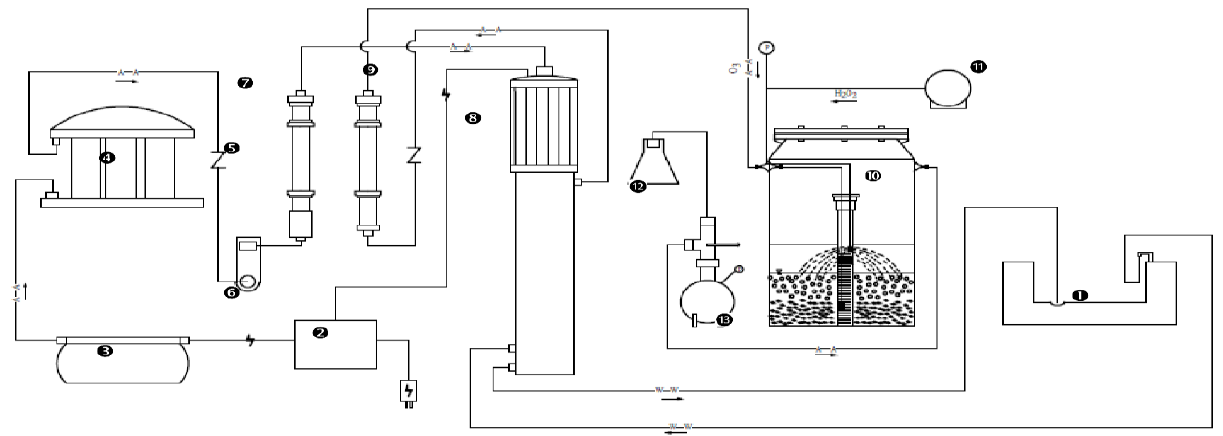
Figure 1. Schematic diagram experimental setup. (1) Cooling water tank; (2) High voltage transformer; (3) Air compression pump; (4) Oxygen generator; (5) Check valve; (6) Flow control valve; (7) Oxygen flow meter; (8) Quartz electrode; (9) Ozone flow meter; (10) Reaction tank; (11) Pump; (12) KI solution; (13) Air compressor.